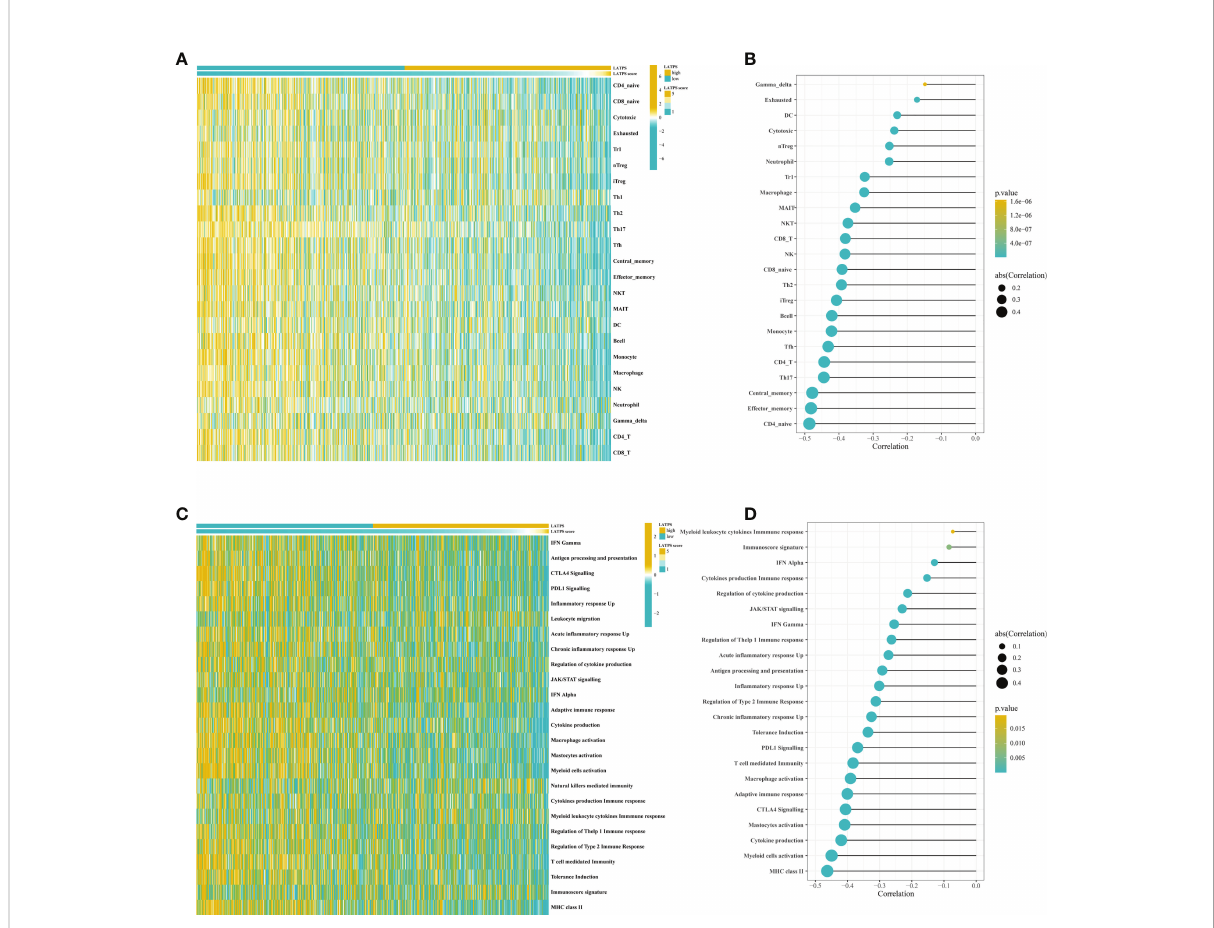
FIGURE 4 The LATPS score is associated with immune cell in fi ltration and immune activation. (A) Heatmap showing the LATPS score and relative abundance of 24 TIICs. (B) Lollipop plot showing the correlation between the LATPS score and the ssGSEA scores of 24 TIICs. (C) Heatmap presenting the LATPS score and GSVA scores of 25 immune-related pathway gene sets. (D) Lollipop plot presenting the correlation between the LATPS score and GSVA scores of 25 immune-related pathway gene sets. LATPS, LUAD tumor microenvironment prognostic signature; TIIC, tumor in fi ltrating immune cell; ssGSEA, single sample gene set enrichment analysis; GSVA, gene set variation